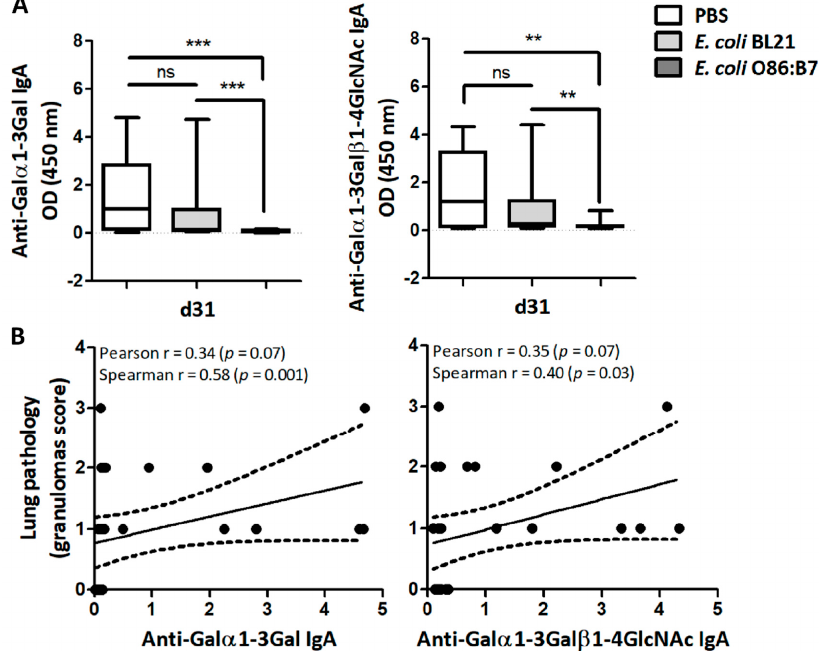
Figure 4. Oral administration of E. coli O86:B7 decreases the levels of anti- α -Gal IgA Abs which correlates with lung pathology in A. fumigatus -infected turkeys. The levels of IgA against α -Gal, Gal α 1-3Gal and Gal α 1-3Gal β 1-4GlcNAc in lungs of A. fumigatus -infected turkeys were measured by ELISA. The levels of anti- α -Gal IgA between groups were compared by one-way ANOVA with Dunnett’s multiple comparison test applied for individual comparisons (** p < 0.001, *** p < 0.0001; ns: not significant, 2 experiments, n = 30 and three technical replicates per sample) ( A ). Correlation between the levels of anti-Gal α 1-3Gal and anti-Gal α 1-3Gal β 1-4GlcNAc IgA and granuloma scores of turkeys treated with PBS, E. coli O86:B7 and E. coli BL21. Pearson and Spearman coefficients r and p values are indicated ( B ).